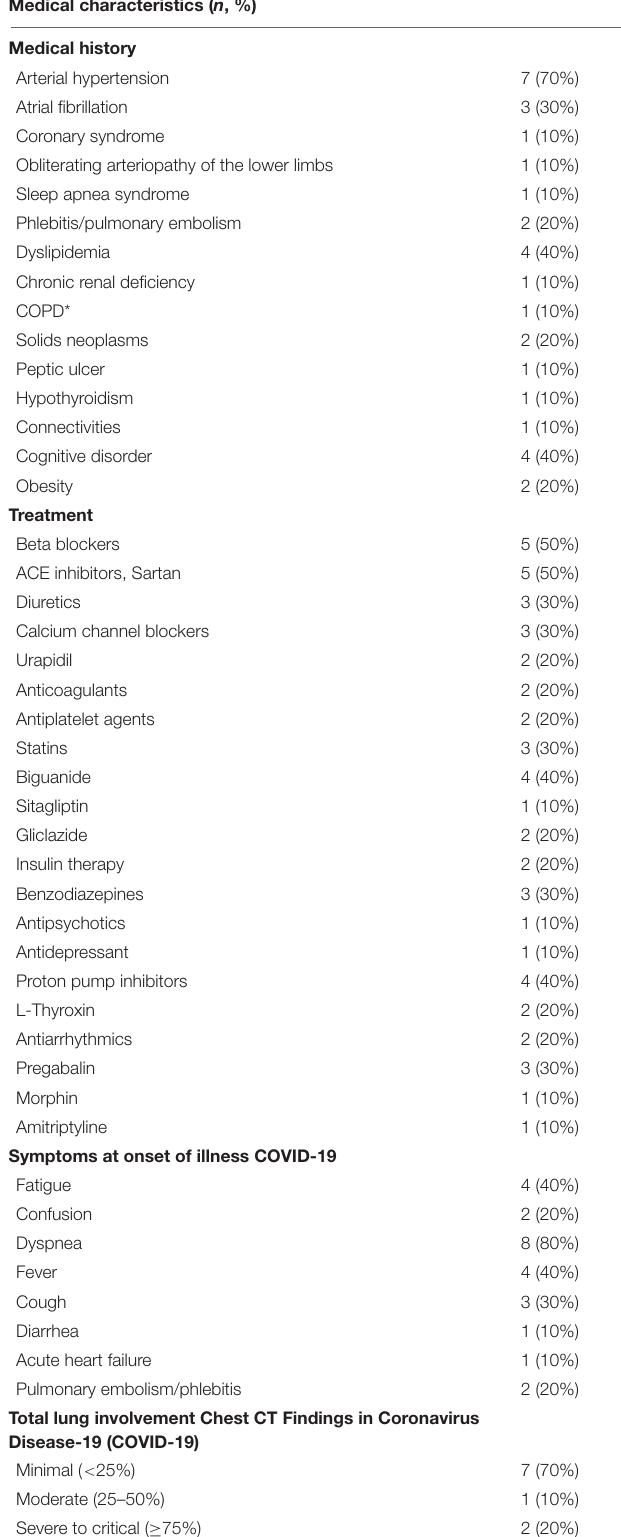
TABLE 1 | Characteristics of the study population ( n =